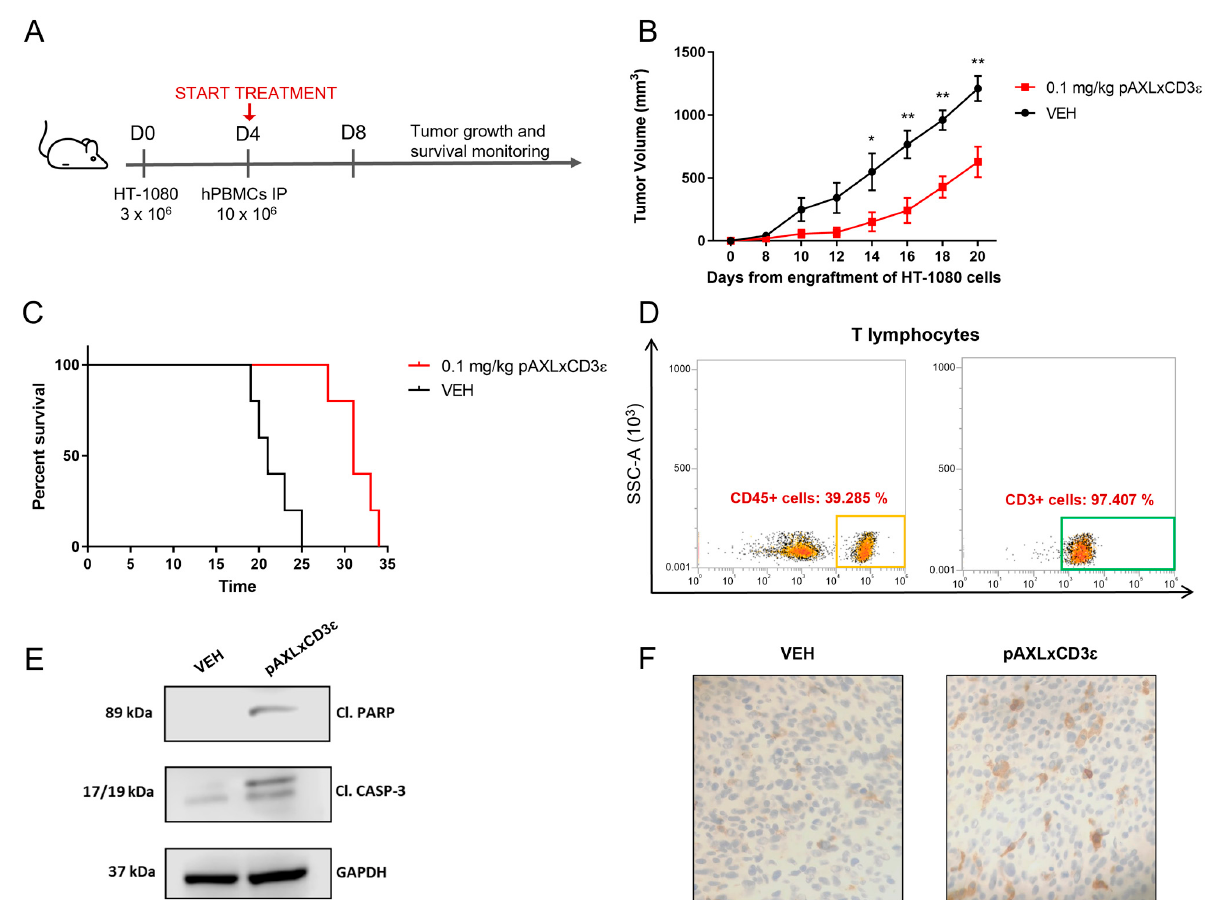
Figure 6. pAXL×CD3 ε in vivo activity. ( A ) Experimental timeline of in vivo study on a sarcoma xenograft model. ( B ) Tumor volume curve of mice treated with pAXL×CD3 ε 0.1 mg/kg or vehicle alone. Results obtained from each group have been compared at the same timepoint for statistical purposes. ( C ) Survival curves (Kaplan–Meier) of mice treated with pAXL×CD3 ε or vehicle. ( D ) Representative FACS dot plots of T-cell engraftment evaluated on the day of sacrifice on intracardiac blood samples collected from mice. CD3-positive cells were evaluated on gated CD45-positive lymphocytes. ( E ) WB analysis of cleaved caspase-3 and cleaved PARP in whole-cell protein extracts from representative retrieved xenografts. GAPDH was used as a loading control. The uncropped blots are shown in Figure S3. ( F ) IHC staining of CD3 lymphocytes performed on tumors explanted from mice treated with vehicle or pAXL×CD3 ε 0.1 mg/kg at 20-fold magnification. * p < 0.0332; ** p < 0.0021.